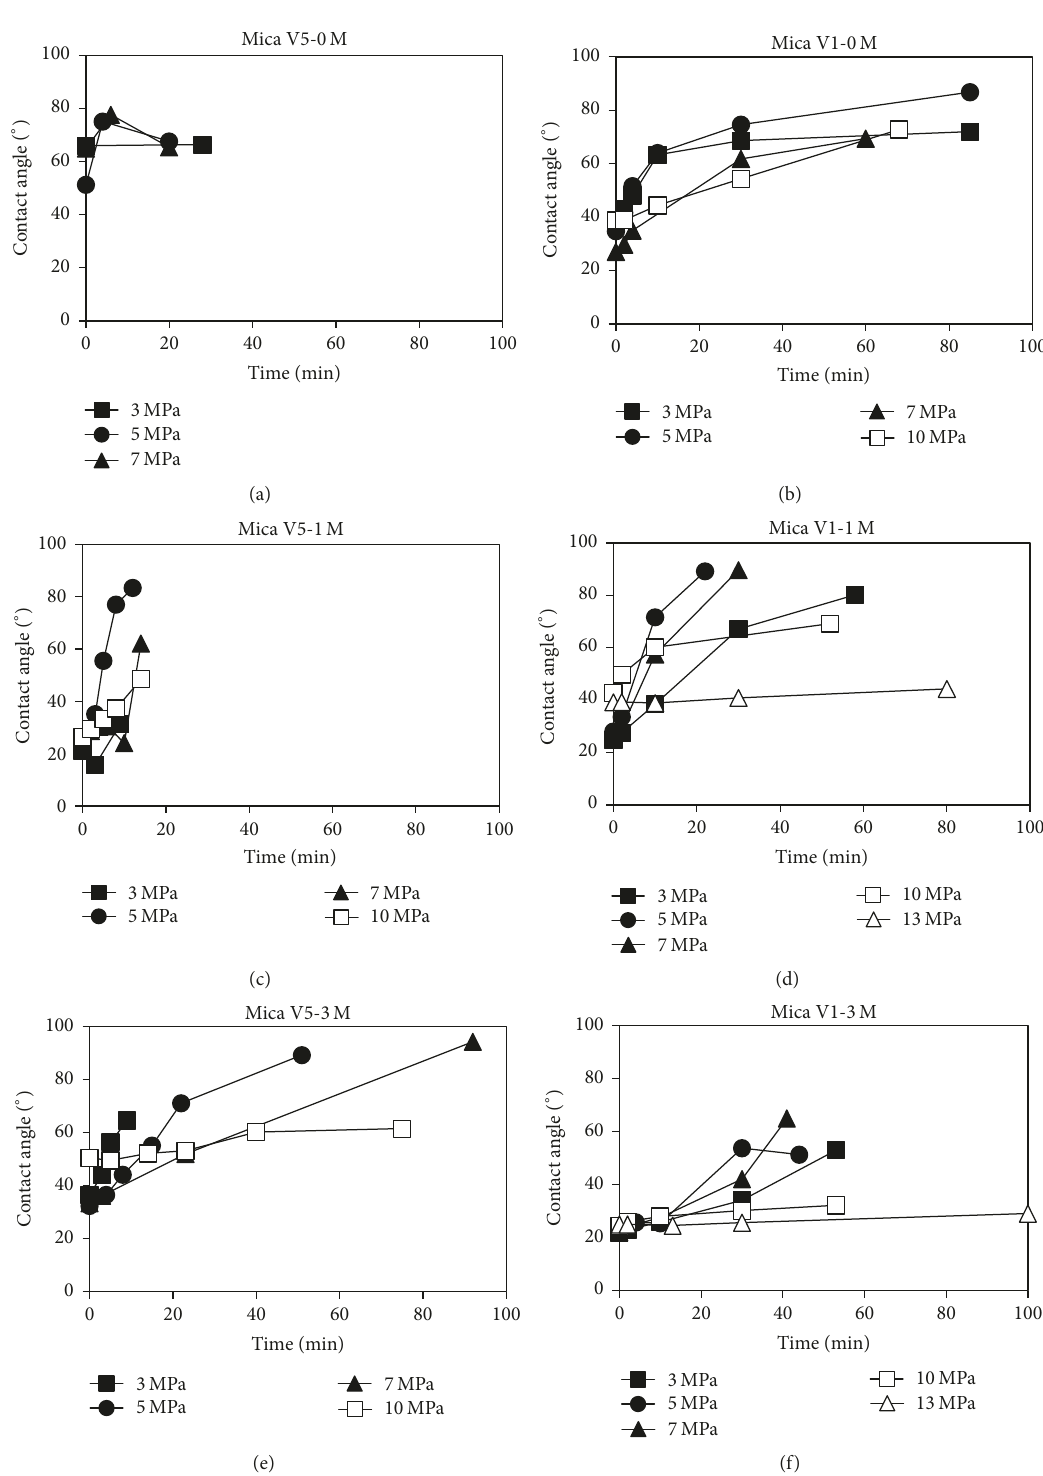
Figure 2: Contact angle change with time on mica substrate. (a) Type V5 with deionized water, (b) type V1 with deionized water, (c) type V5 with 1 MNaCl, (d) type V1 with 1MNaCl, (e) type V5 with 3 MNaCl, and (f) type V1 with 3